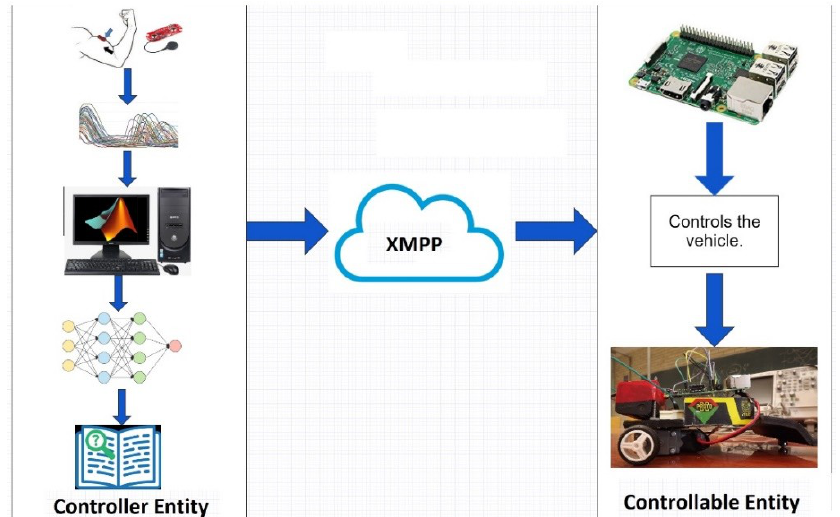
Figure 5. Basic scheme of the proposed project. It is composed of the controller entity and the controllable entity.